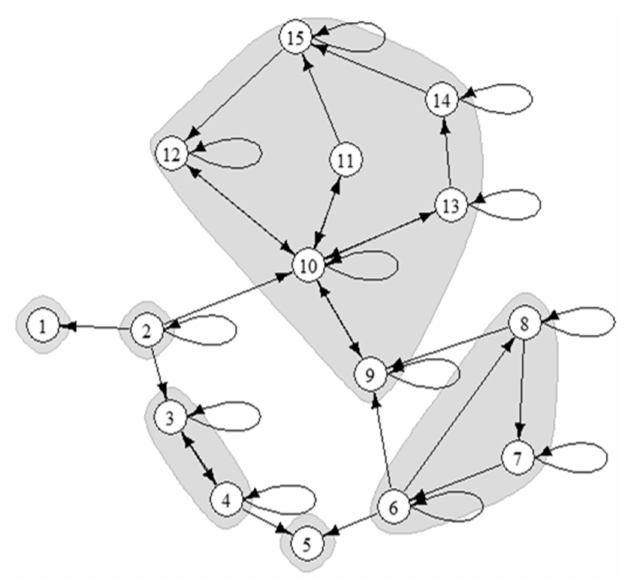
Figure 2. Strong subgroups and satellites in model